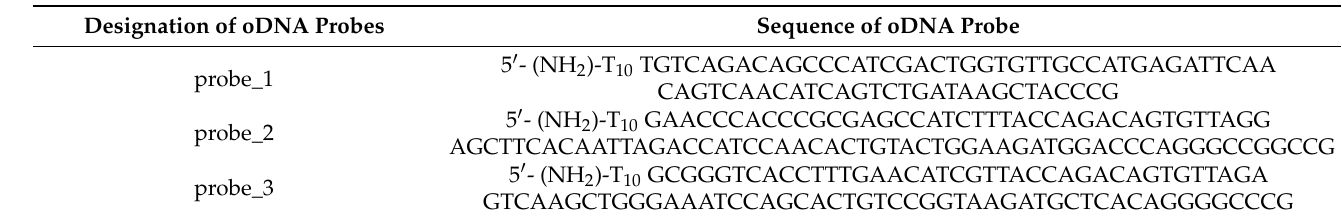
Table 2. Nucleotide sequences of oDNA probes immobilized on the nanowire surface. Designation of oDNA